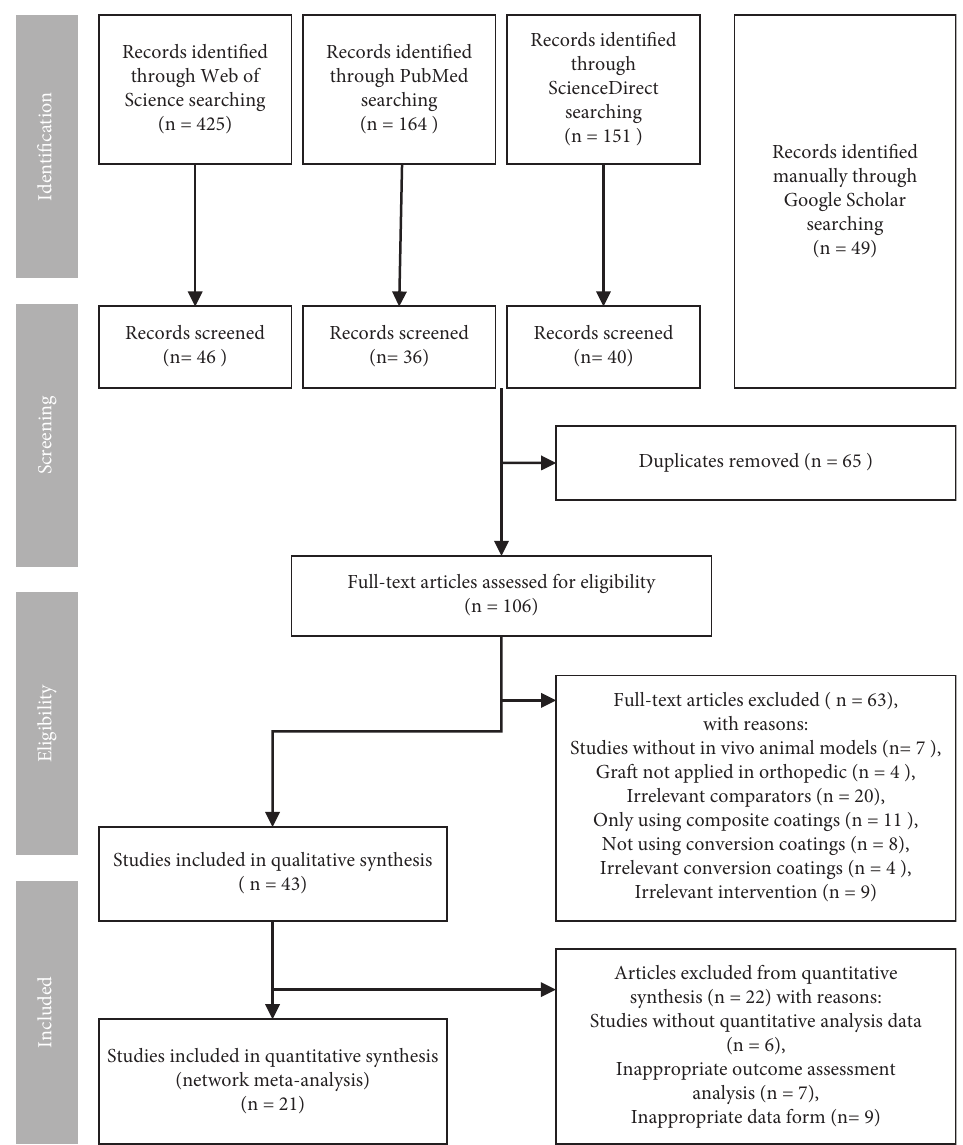
Figure 2: PRISMA